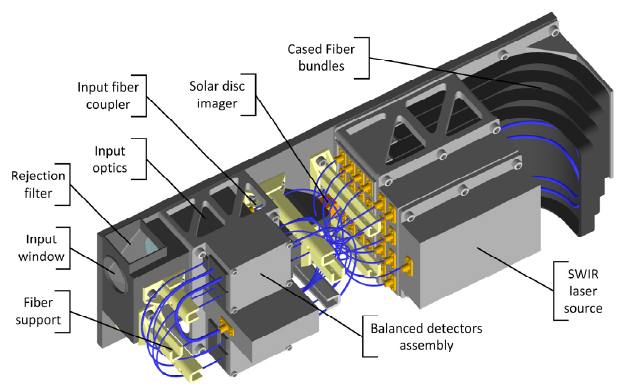
Figure 4. Three-dimensional CAD model of the SWIR LHR instrument. The volume envelope of the instrument is ~10 × 10 × 30 cm 3 .